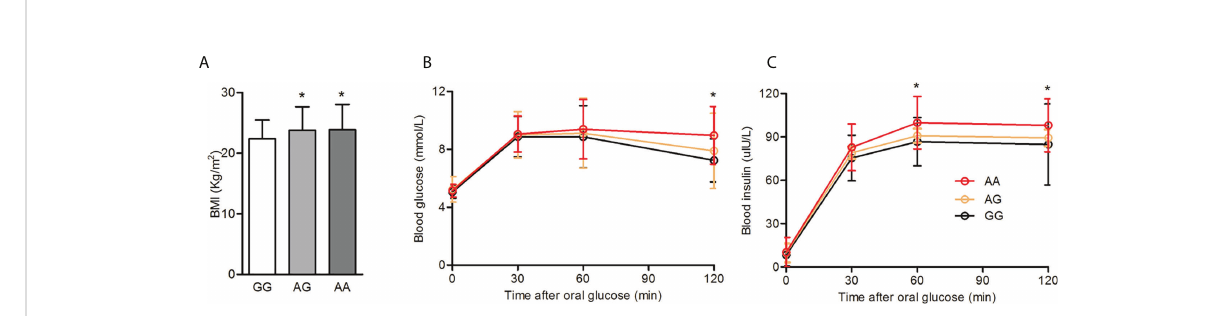
FIGURE 3 BMI and glucose tolerance among different genotypes of rs4953361. (A) : Comparison of BMI among different genotypes of rs4953361. (B, C) : Comparison of the OGTT and IRT among different genotypes of rs4953361. *p < 0.05 compared with the GG